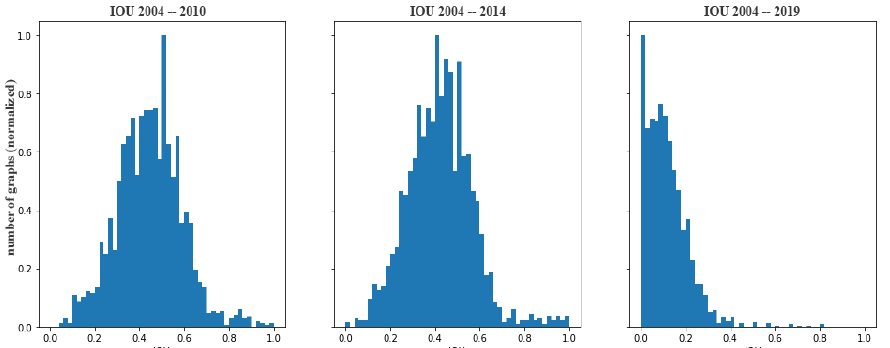
Figure 9. IOU histograms for matching graph geographic areas obtained for Meurthe-en-Moselle department. If all the nodes attributes match exactly (injective matching) across graphs, the IOU value will be 1.